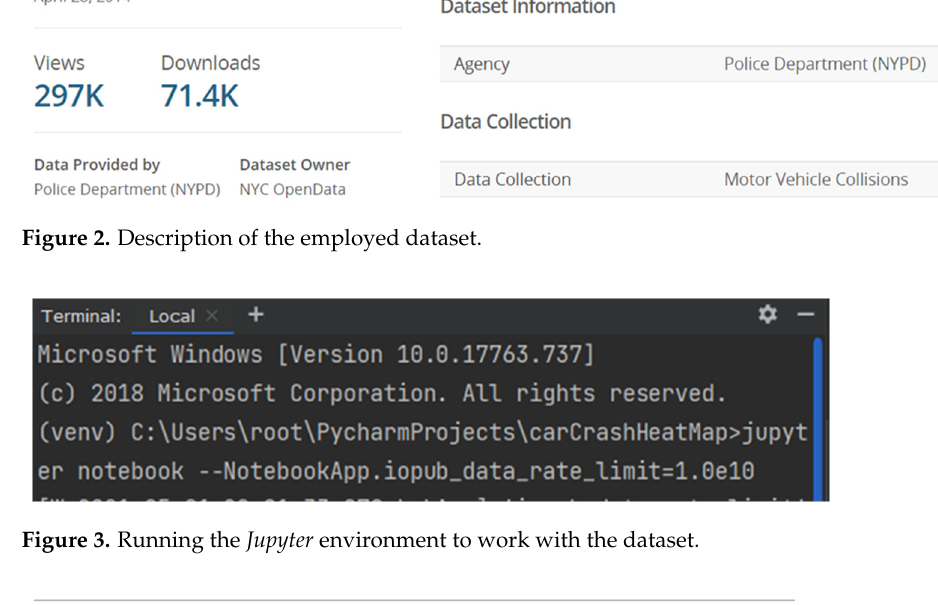
Figure 2. Description of the employed dataset.